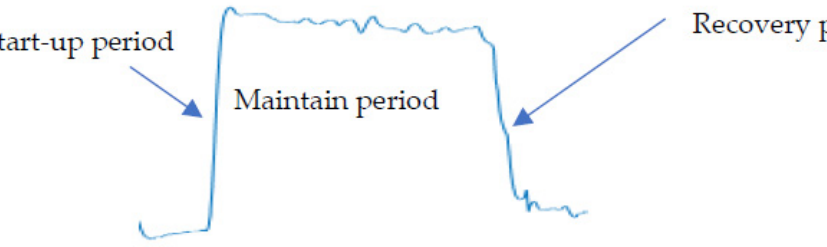
Figure 6. The change of FMG signal for one repetition of a gesture. It contains start-up period, maintain period, and recovery period.